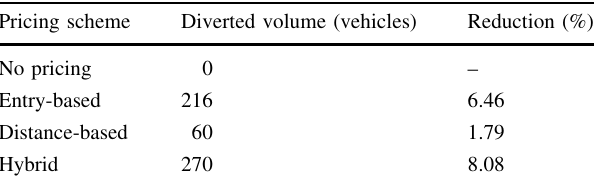
Table 8 Diverted flow from cordoned area for different toll designs for Sioux Falls Pricing scheme